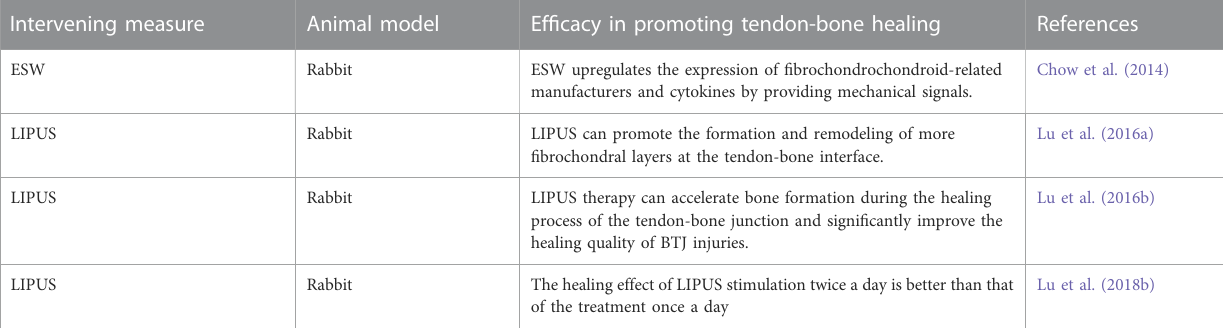
TABLE 5 Preclinical studies of mechanical stimulation in promoting tendon-bone healing in ACL reconstruction. Intervening